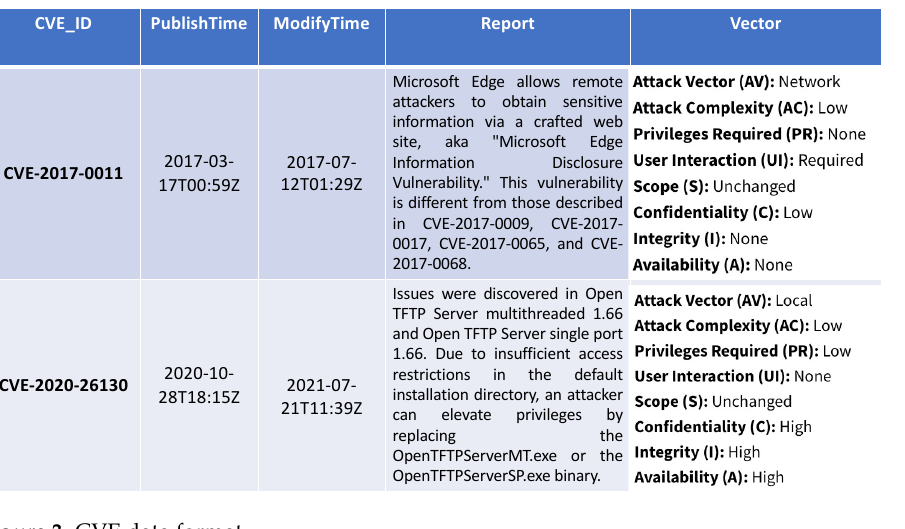
Figure 3. CVE data format.